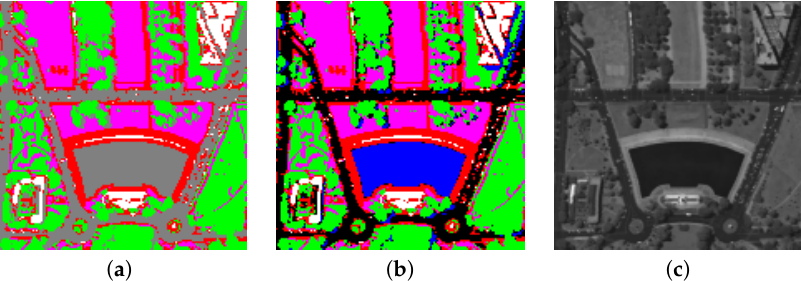
Figure 5. Partitions of Washington DC with ( a ) five clusters and ( b ) six clusters. The average band of that image is also shown for reference ( c ). Materials in Figure 5a: Roof (white), Grass (magenta), Trail (red), Tree (green), and Road plus Water (gray). Materials in Figure 5b: Roof (white), Grass (magenta), Trail (red), Tree (green), Road (black) and Water